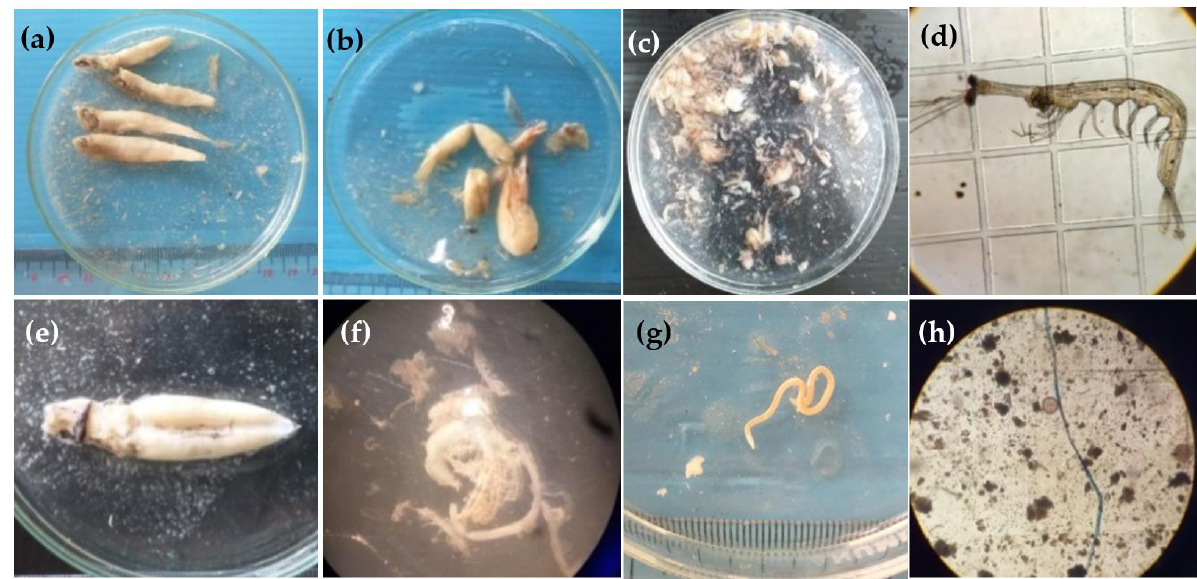
Figure 2. Examples of fish stomach content: ( a ) fish, ( b ) penaeid shrimp, ( c ) Acetes sp., ( d ) Lucifer sp., ( e ) squid, ( f ) hermit crab, ( g ) nematode, and ( h ) anthropogenic debris. The average number of food types (AF) ranged from 2 ( T. lepturus ) to 16 ( E. splendens ) types (Table 1). More than 10 food types were found mostly in planktivores, whereas fewer than 8 types were found in piscivorous fishes. The fish that had high AF were considered opportunist feeders. AF of individual fish was influenced significantly by water depth and season ( p < 0.05), especially for most of the planktivorous fish, some Lucifer feeders, and one zoobenthivorous fish ( J. borneensis ) (Table 1). On the contrary, planktivorous fish such as Anodontostoma chacunda , Planiliza subviridis , some Lucifer feeders ( Alepes kleinii and A. vari ), Acetes feeders (S. waitei ), shrimp feeders ( Thryssa